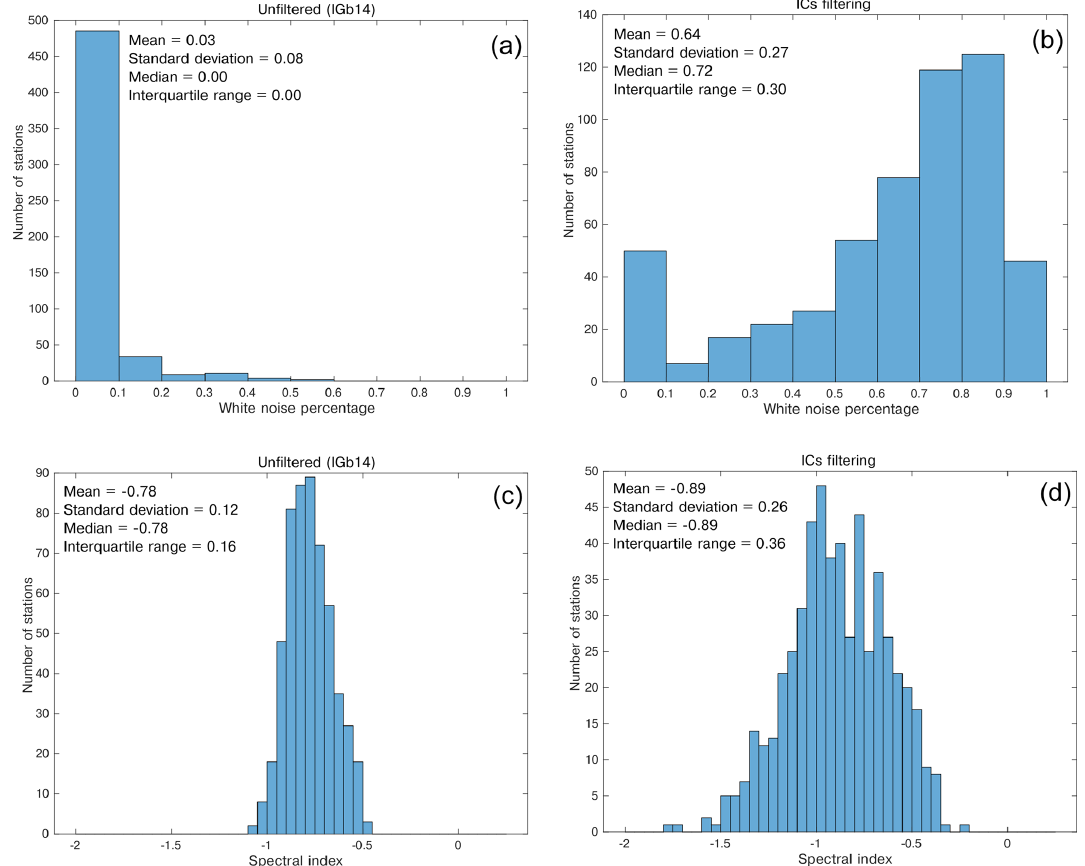
Figure 12. Histograms of (a) white noise percentage in the unfiltered time series and (b) filtered time series. Panels (c) and (d) are the same as (a) and (b) but for the spectral index. The filtering is done by subtracting the displacements associated with the first four